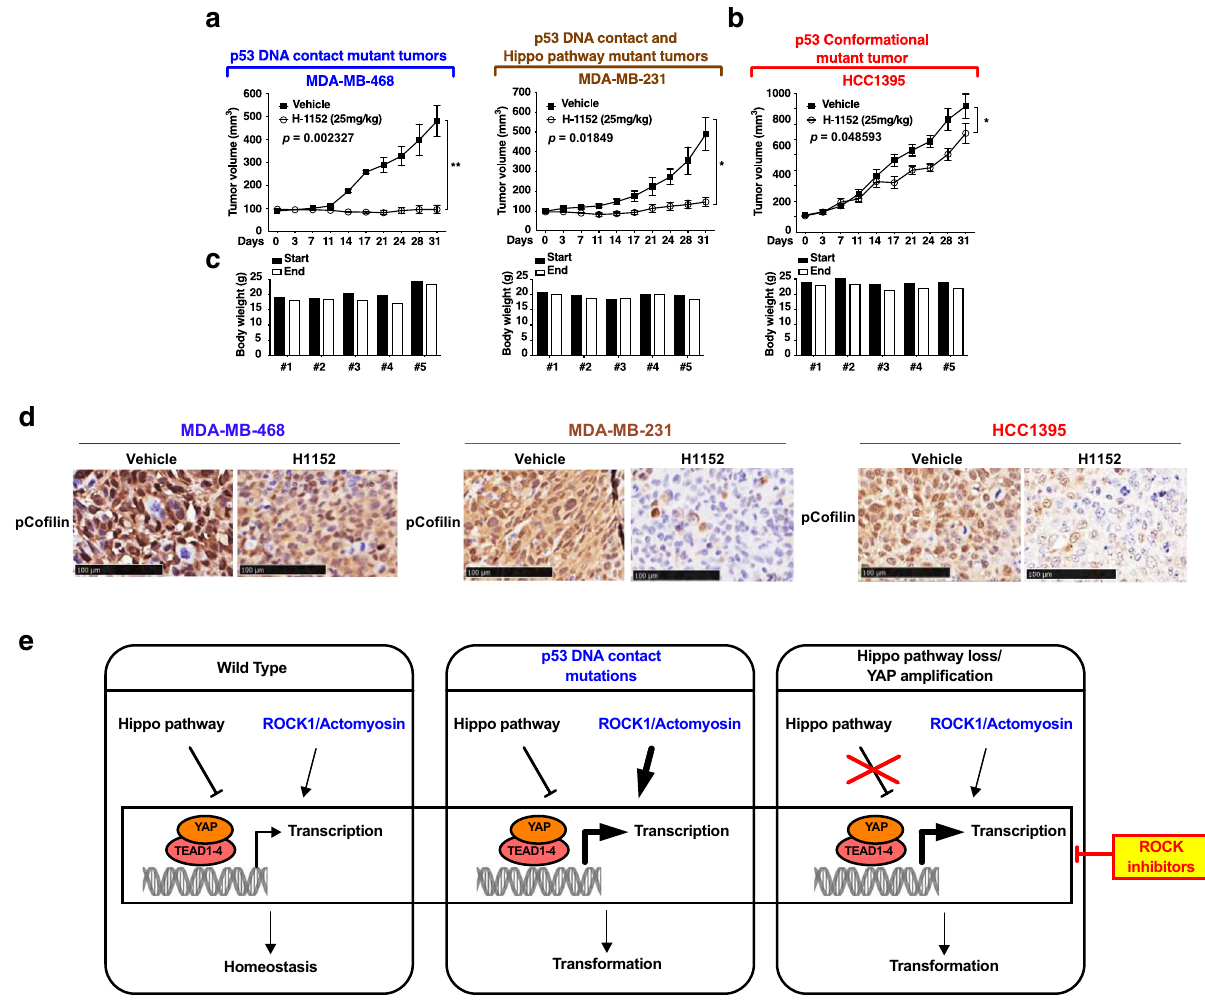
Fig. 5 ROCK inhibition selectively antagonizes in vivo growth of TEAD/YAP driven human tumors. a – c Tumor cell growth following orthotopic inoculation in immunocompromised mice of MDA-MB-468, MDA-MB-231 ( a ) or HCC1395 cells ( b ) followed by daily dosing of H-1152 (25 mg/kg) after tumors reached a volume of 100 mm 3 . n = 5 mice per group were used. p values are indicated in the fi gure calculated using two tailed t -test for n = 5 biologically independent mice per group. Body weight of each mouse at the beginning and at the end of the treatment is also shown ( c ). d Immunostaining of tumor sections from ( a , b ) with antibodies directed against pCo fi lin as described in the Methods. Scale bar: 100 µ M. n = 5 biologically independent mice per group. e Model depicting inhibition of TEAD/YAP transcription in physiological conditions, activated by p53 DNA contact mutations or Hippo pathway alterations by ROCK inhibitiors.* p < 0.05, ** p < 0.01. Source data with actual calculated p values are provided as Source data fi